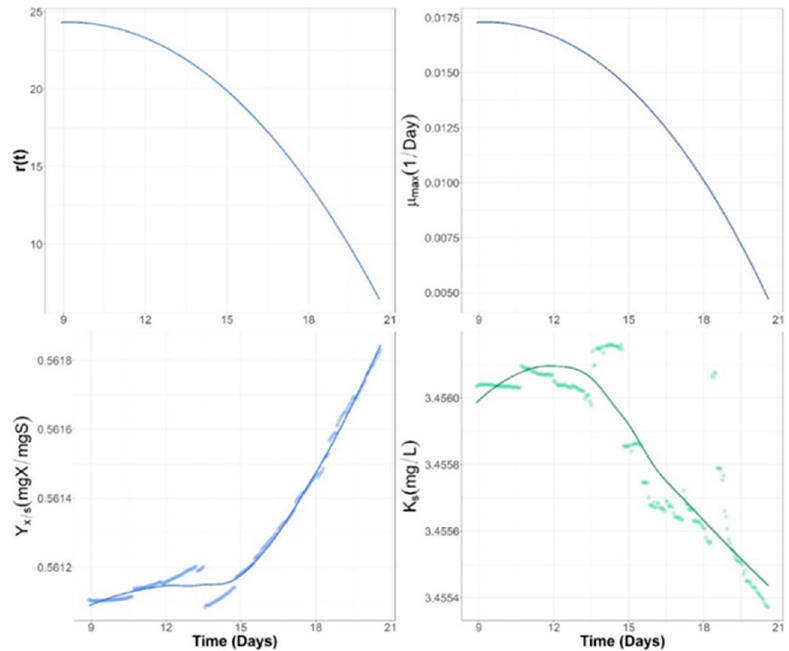
Figure 5. 𝜇 (cid:3040)(cid:3028)(cid:3051) , 𝐾 (cid:3046) , 𝑌 (cid:3051)/(cid:3046) , and r(t) obtained for a mass balance model of COD in HFCW. Figure 5. µ max , K s , Y x / s , and r ( t ) obtained for a mass balance model of COD in